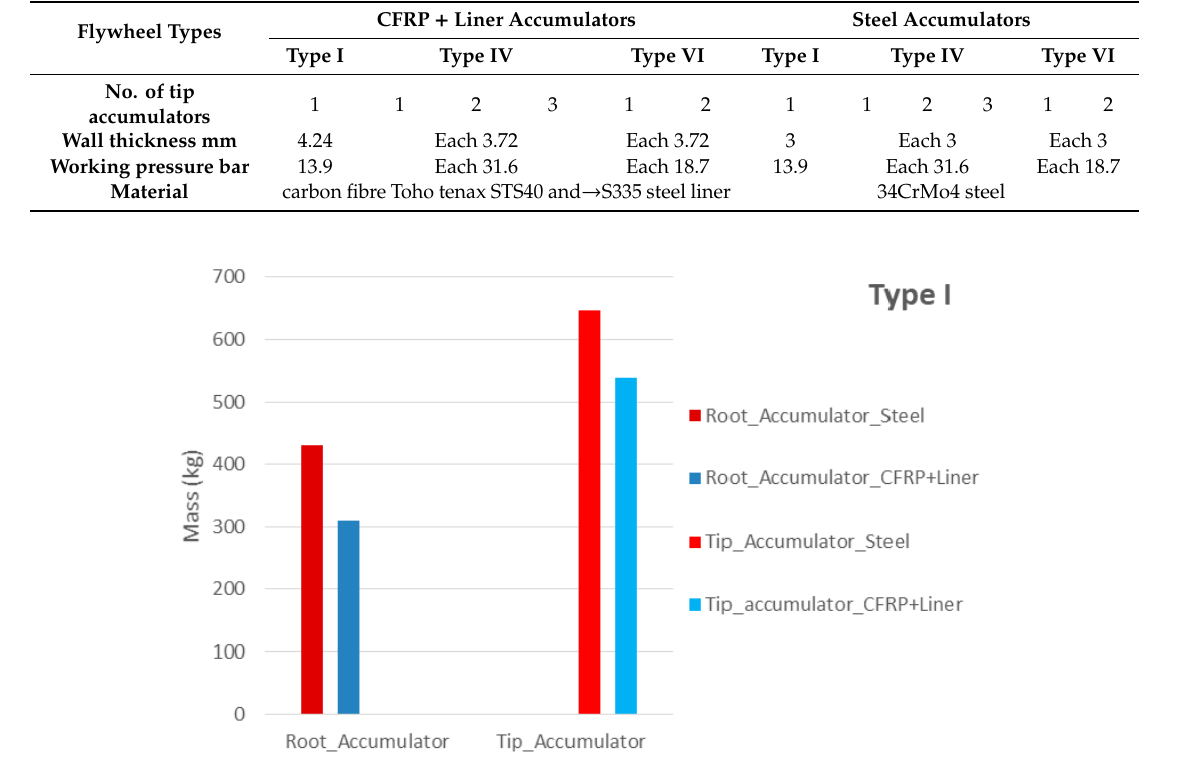
Table 4. Properties of the CFRP and the conventional piston accumulators of the three FW types.